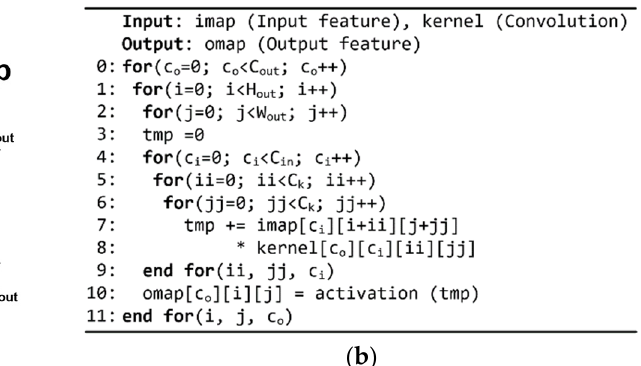
( c ) Figure 3. Matrix multiplication dimension, tiling, and mapping of two types of accelerators: ( a ) Tiled matrix on CNN matrix multiplication; ( b ) Matrix multiplication on SIMD; and ( c ) Systolic array.